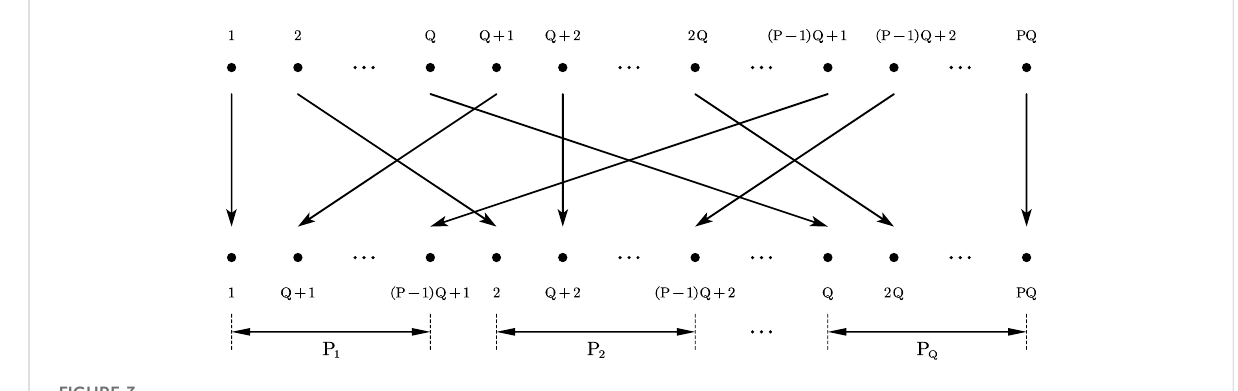
FIGURE 3 Schematic diagram of sequence decimating and rearranging.